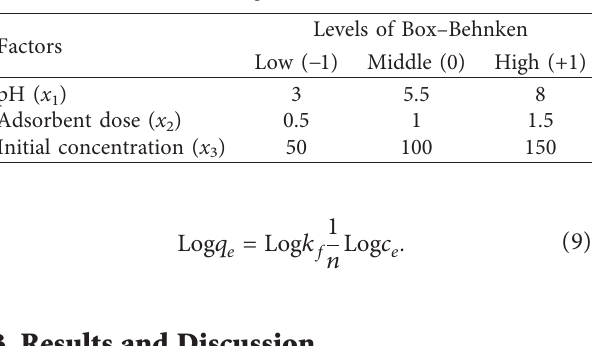
Table 1: Coded and real values of operational parameters for the Box–Behnken statistical